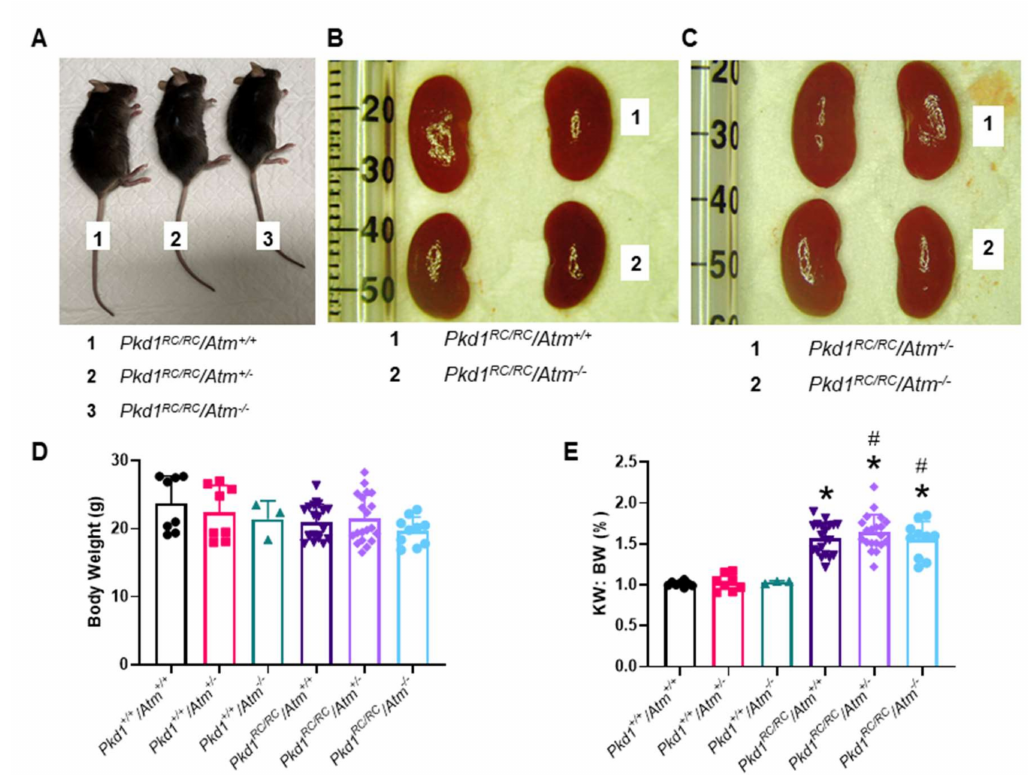
Figure 6. Effect of ATM reduction on the progression of cystic kidney disease in Pkd1 RC/RC mice at 3 months of age. ( A ) Representative macroscopic appearance of male Pkd1 RC/RC mice either with Atm +/+ (wild-type), Atm +/ − (heterozygous), or Atm − / − (homozygous) genotype, and this was similar in all experimental groups. ( B ) and ( C ) Representative images of Pkd1 RC/RC mouse kidneys with either Atm +/+ or Atm − / − genotype. ( D ) Mean body weight of the experimental groups. ( E ) Mean two kidney weight to body weight ratio (KW: BW) in the experimental groups. * p < 0.05 compared to wild-type mice ( Pkd1 +/+ /Atm +/+ ) and # p < 0.05 compared to Atm genotype matched Pkd1 +/+ . Data presented as means ± SD ( n = 8 per wild-type group; n = 4 males and n = 4 females; n = 20 per Pkd1 RC/RC mouse group; n = 10 males and n = 10